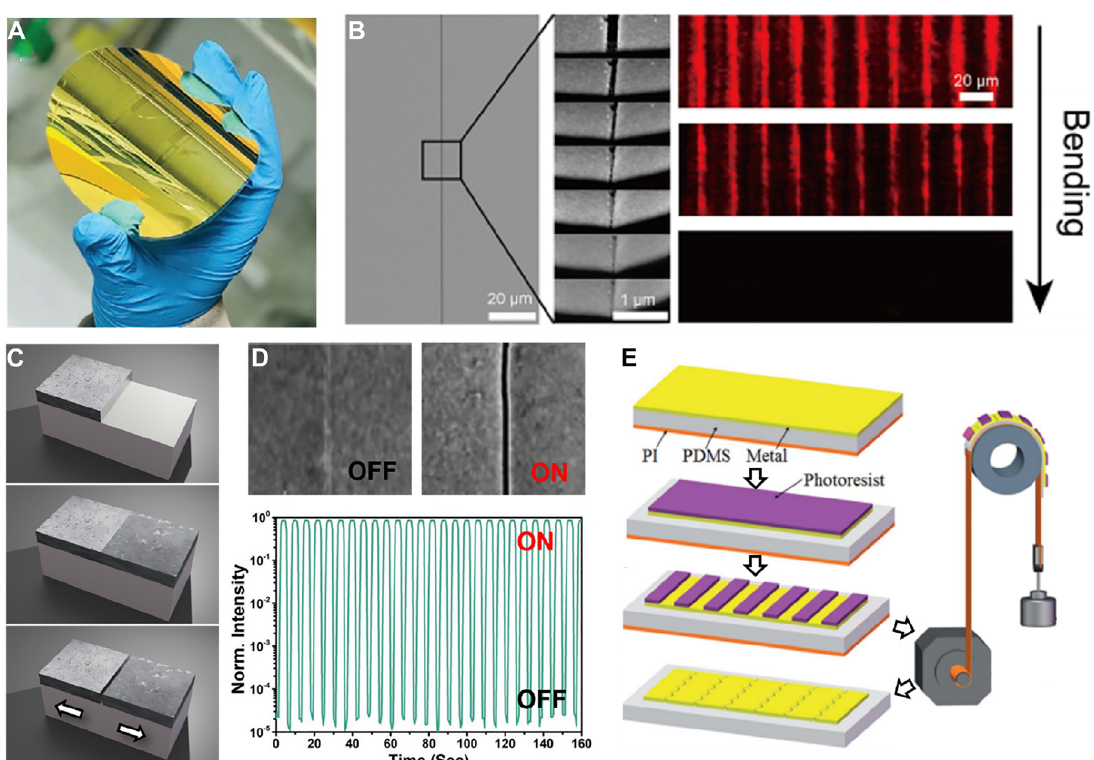
Figure 17: Healable crack-based metallic gaps fabricated on flexible substrates. (A) An optical image of wafer-scale metallic gaps on a flexible substrate. (B) SEM images and optical transmission images of metallic gaps upon bending the substrate and thereby closing the gap. (C) Schematic description of a ‘ zerogap ’ , where a crack is prepatterned at the boundaryoftwometalliclayersdepositedatdifferenttimeswithdifferentconditions.(D)SEMimagesofa ‘ zerogap ’ at ‘ off ’ and ‘ on ’ states,and transmittancethroughthegaparrayatrelativestates.(E)PatterningcracksonaPDMSsubstratebyphotolithographyandpreciselycontrolled bending of the substrate. Reproduced with permission from [27] (A), (C) and (D) [189], (B) [190],